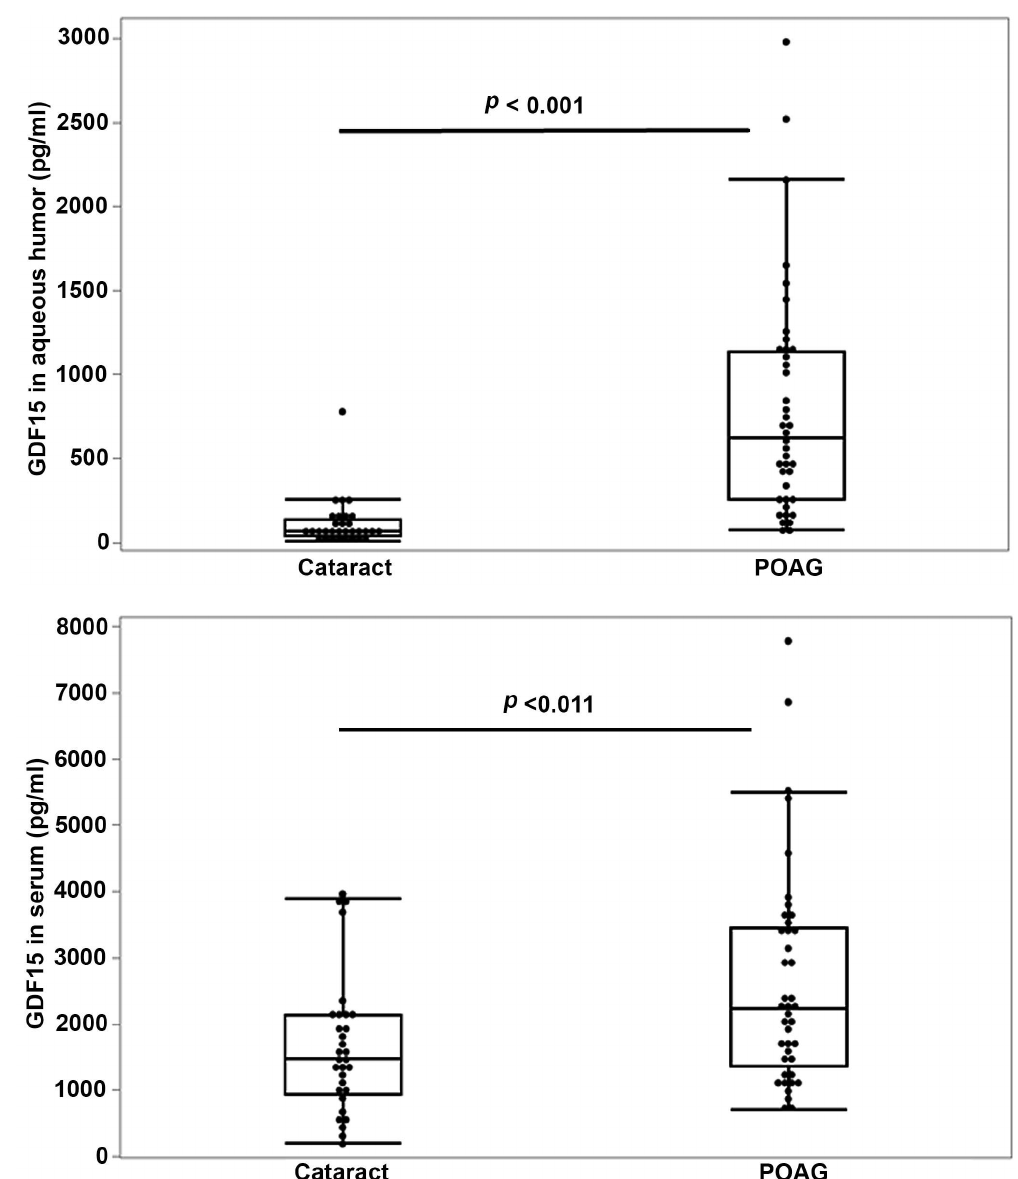
Figure 1. Elevated levels of GDF15 in aqueous humor and serum samples of POAG patients. Aqueous humor ( n = 40) and serum ( n = 41) samples derived from POAG patients revealed significantly elevated levels of growth/differentiation factor-15 (GDF15) (by > 9-fold and 50%, respectively) compared to age- and gender-matched cataract patient samples ( n = 32). The box and whisker plots represent median and the interquartile range in the distribution. p -values were based on the Wilcoxon rank sum test of difference between medians. Abbreviations: GDF15, growth/differentiation factor-15; POAG, primary open-angle glaucoma.